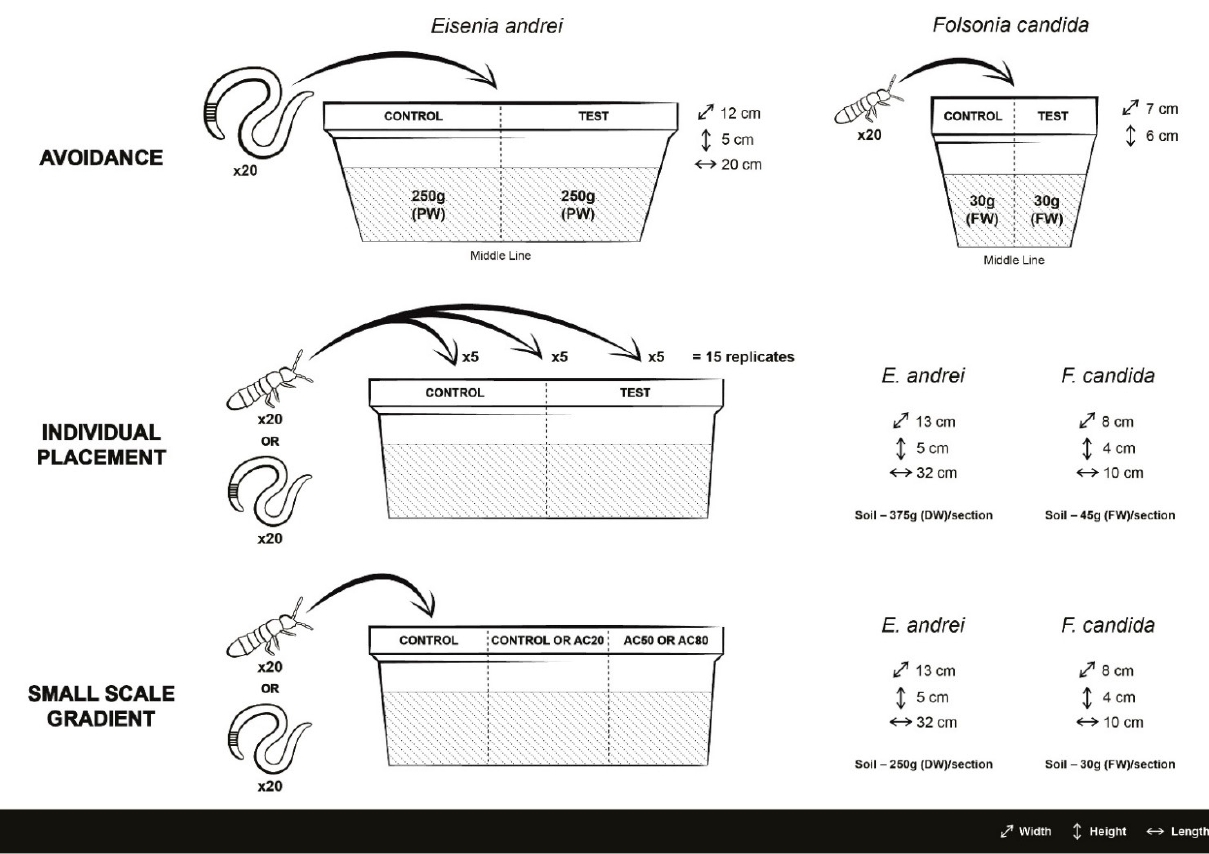
Figure 1. Visual scheme depicting test vessels and experimental procedures for the avoidance, individual placement and small-scale gradient tests.